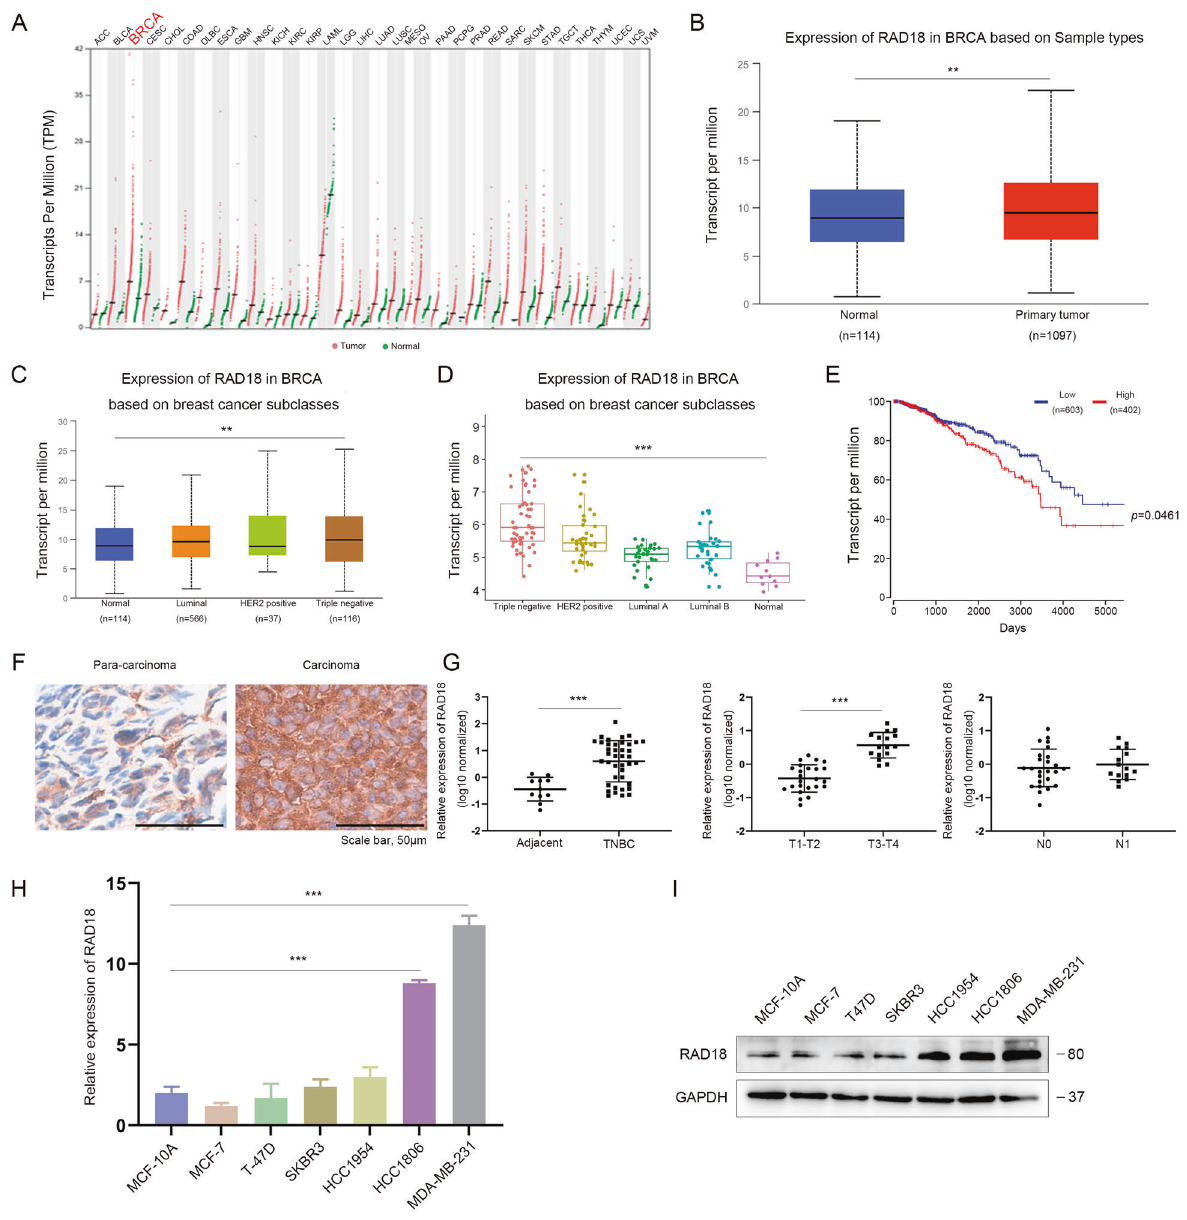
Fig. 1 RAD18 is high expression in TNBC and positively correlates with poor prognosis. RAD18 expression is frequently elevated in TNBC and associated with poor prognosis of TNBC patients. A RAD18 was relatively high expressed in breast cancer than any other cancer types. B The expression level of RAD18 was higher in TNBC tissues ( n = 1097) compared to the surrounding normal tissues ( n = 114). C , D RAD18 was especially high expression in TNBC according to TCGA database and GSE65194. E Kaplan – Meier survival analysis revealed that high RAD18 expression associated with a shorter overall survival (OS) compared to low RAD18 expression in TNBC patients ( p = 0.0461). F Immunohistochemical analysis of RAD18 in 40 TNBC tissues samples (400×). G The expression of RAD18 was signi fi cantly higher in TNBC tissues ( n = 40) than adjacent normal tissues ( n = 10). The RAD18 expression level correlated with T tumor stages ( n T1-T2 = 24, n T1-T2 = 16 ), but not with lymph node metastasis ( n N0 = 25, n N1 = 15 ). H , I qRT-PCR and western blot showed that MDA-MB-231 and HCC-1806, as the TNBC cell lines, high expressed RAD18 compared to normal mammary epithelial cells (MCF-10A) and other breast cancer subtypes cell lines. * p < 0.05, ** p < 0.01, *** p < CSCs. As shown in Fig. 3G, silencing RAD18 in TNBC cells reduced the number and size of tumor spheres. The in fl uence of RAD18 levels on stemness-associated genes in TNBC was also investi- gated. The qRT-PCR and WB results proved that silencing RAD18 reduced the expression of stemness-related genes such as CD44, Nanog, SOX2, and OCT4 in TNBC cells (Fig. 2H – I). Overall, the results demonstrated that RAD18 plays an important role in the maintenance of the stem cell character- istics of TNBC.